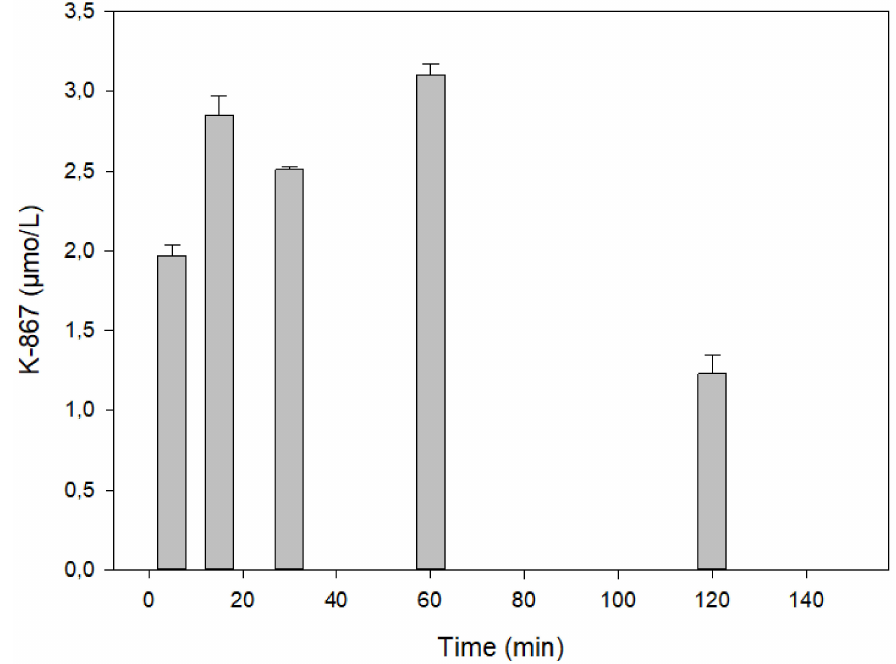
Figure 6. Time course of K867 content in the brain following its intramuscular administration of 30 µ mol.